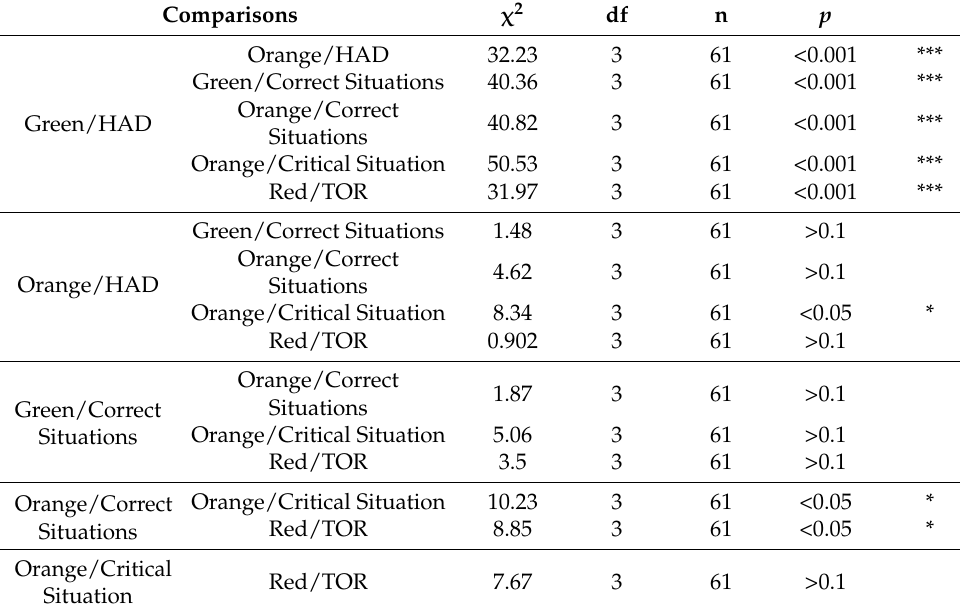
Table 5. Chi-squared results for the several